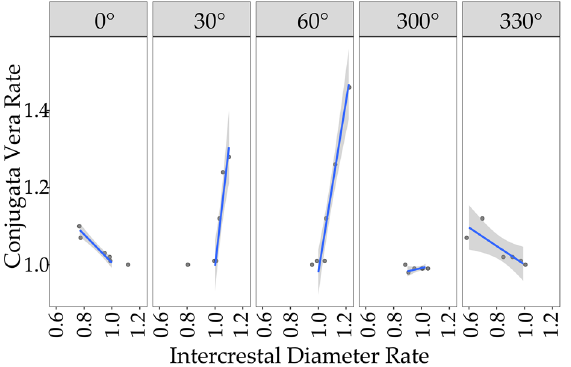
Figure 17. Correlation between the IC and CV change rates in the impact loading conditions of 0°, 30°, 60°, 300°, 330°. 30 ◦ , 60 ◦ , 300 ◦ , 330 ◦